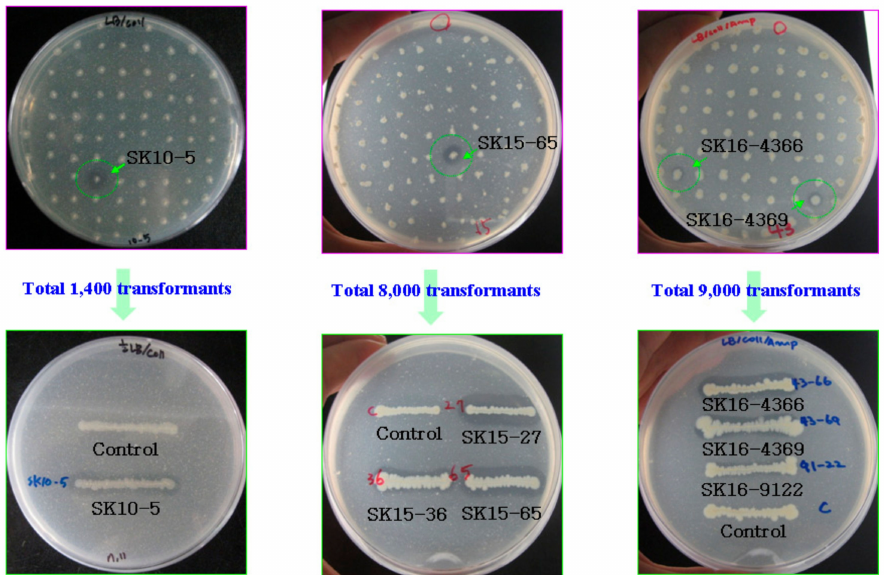
Figure 3. Screening of chitinase-positive clones using LBCC/ampicillin plates. The clones were streaked on LBCC/ampicillin plates and incubated for three days at 30 ◦ C. The positive clones were streaked on the same plates and compared with a control, which was transformed with a pUC19 vector.